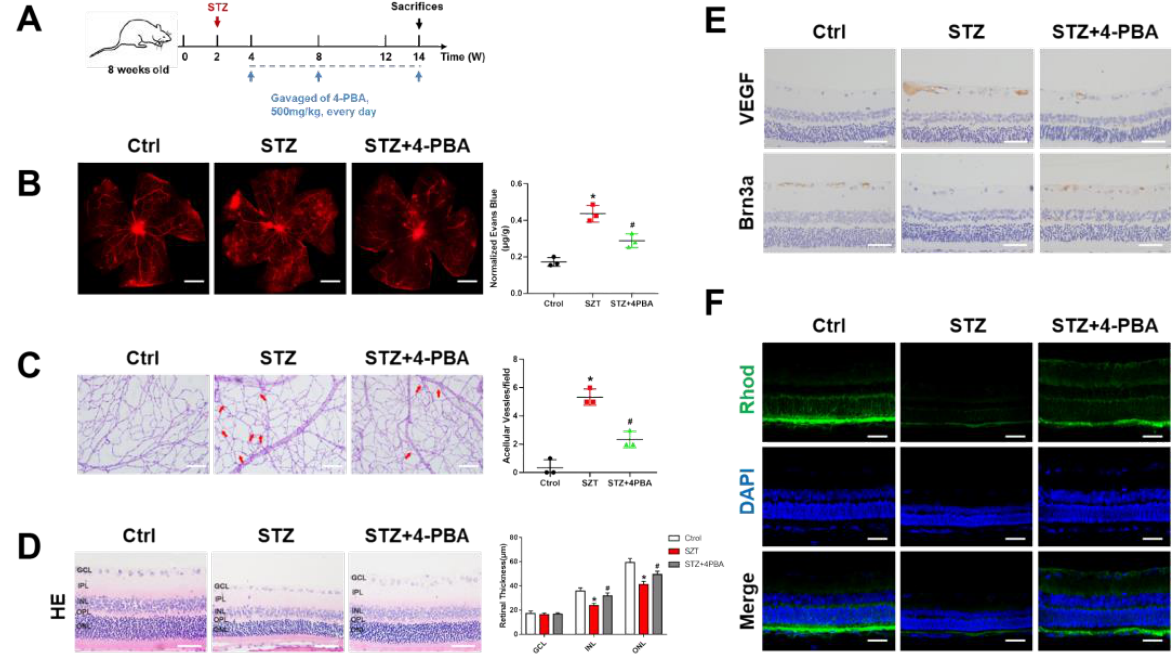
Figure 6. Inhibition of ERS ameliorated retinal dysfunction in DR rats. ( A ) Schematic presentation of in vivo procedures. ( B ) Rats with a tail vein injection of Evans blue dye (3%) for 2 h. Red fluorescent spots indicate retinal vascular leakage. ( C ) Representative images of acellular capillaries are shown by retinal trypsin digestion experiments and quantified by randomized regions. Scale bars = 50 µ m. ( D ) Representative images of HE staining of rat retinas. The thickness of ONL, INL, and GCL layers of rats were assessed in the sections. Scale bars = 50 µ m. ( E ) Immunohistochemistry analysis of VEGF and Brn3a in retinas. Scale bars = 50 µ m. ( F ) Immunofluorescence staining for Rhod (green) and DAPI (blue) was performed in rat retinal sections. Scale bars = 50 µ m. Data are presented as mean ± SD. * p < 0.05 vs. control group, # p < 0.05 vs. STZ group.